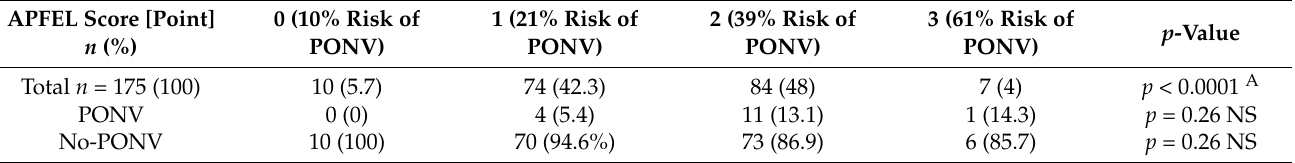
Table 3. Apfel score of patients according to postoperative presence or absence of